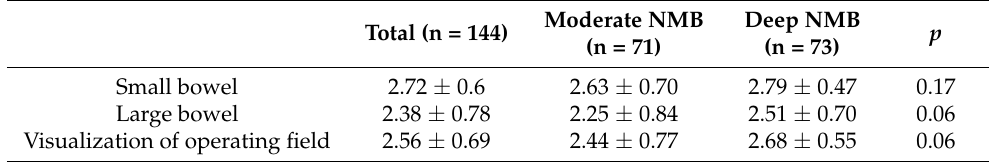
Table 2. Surgeon rating of operating field.